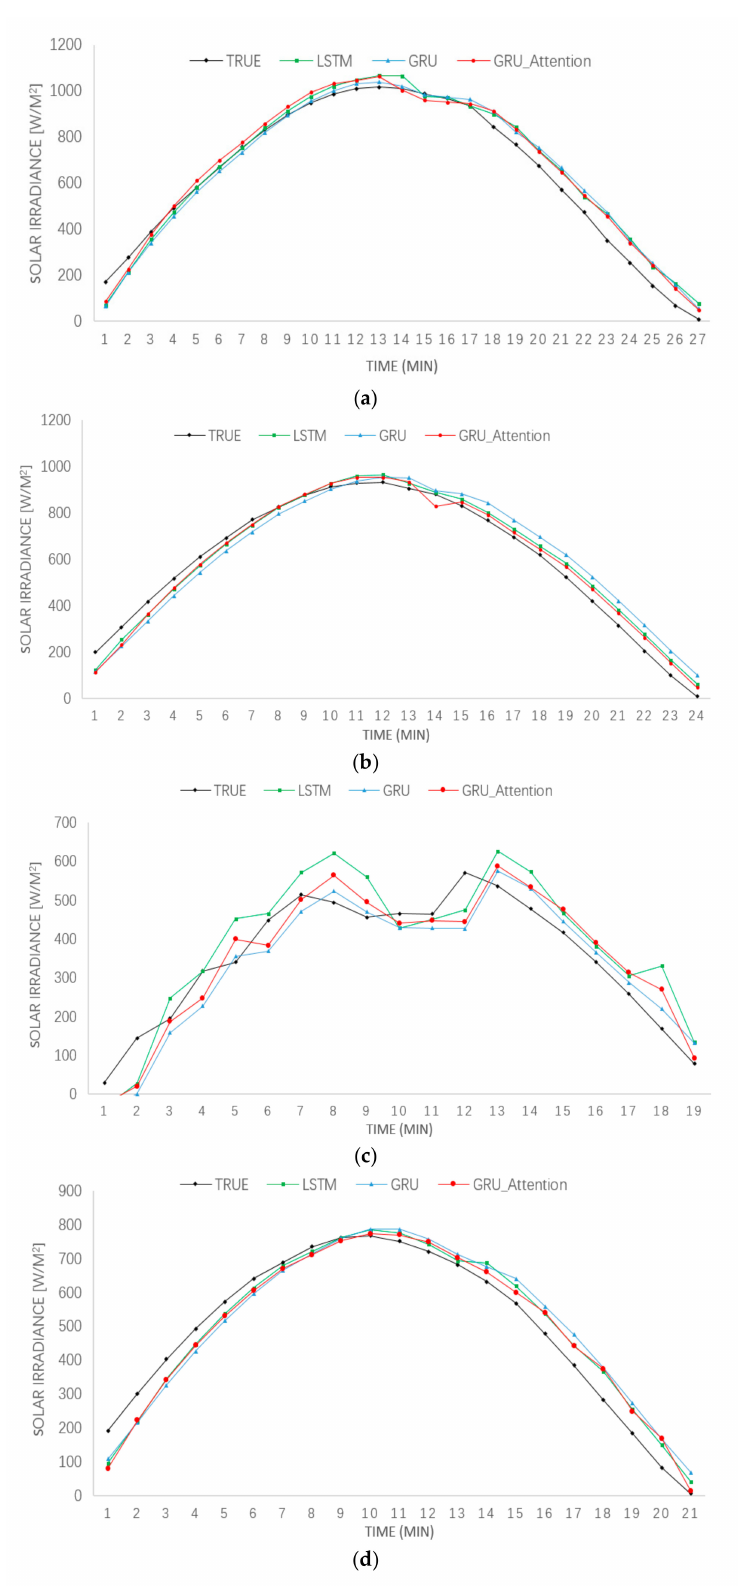
Figure 10. The experimental results of each model in which the photovoltaic irradiance prediction time interval is 30 min in 2014. ( a ) spring; ( b ) summer; ( c ) autumn; ( d )